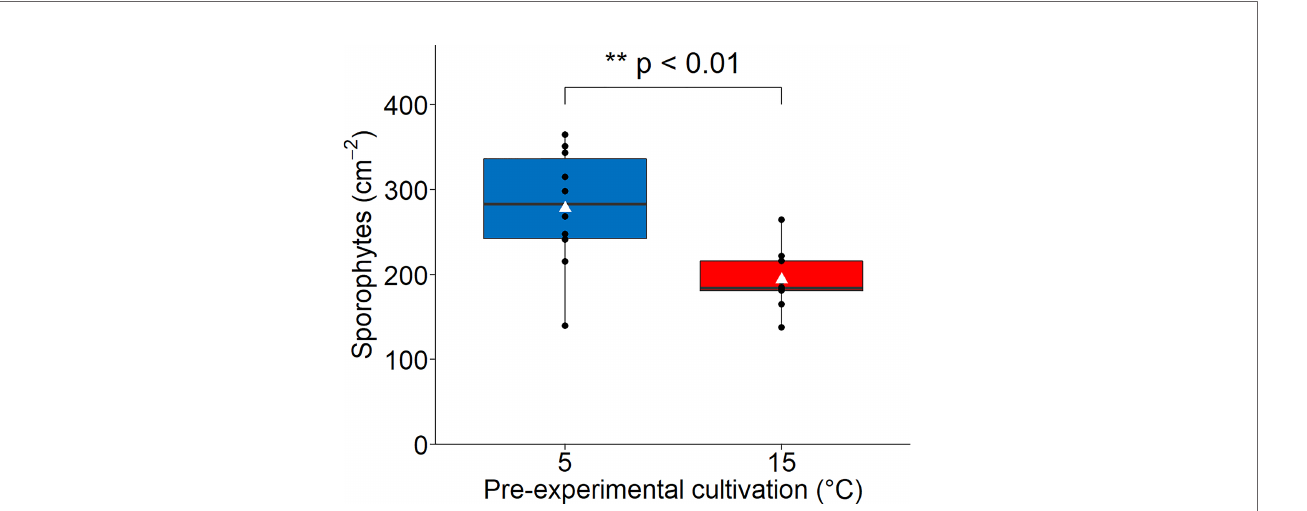
FIGURE 3 | Absolute number of Laminaria digitata microscopic sporophytes after 14 days of gametophyte fertilization at 10°C (step 1) following pre-experimental cultivation (PEC) of parental gametophytes at 5°C and 15°C (n = 10). Boxplots represent the median as a line; triangle as the mean density of sporophytes; interquartile range as a box; minimum and maximum values as whiskers; dots as single replicates. Asterisks represent signi fi cant differences between PECs (p < 0.01, Student